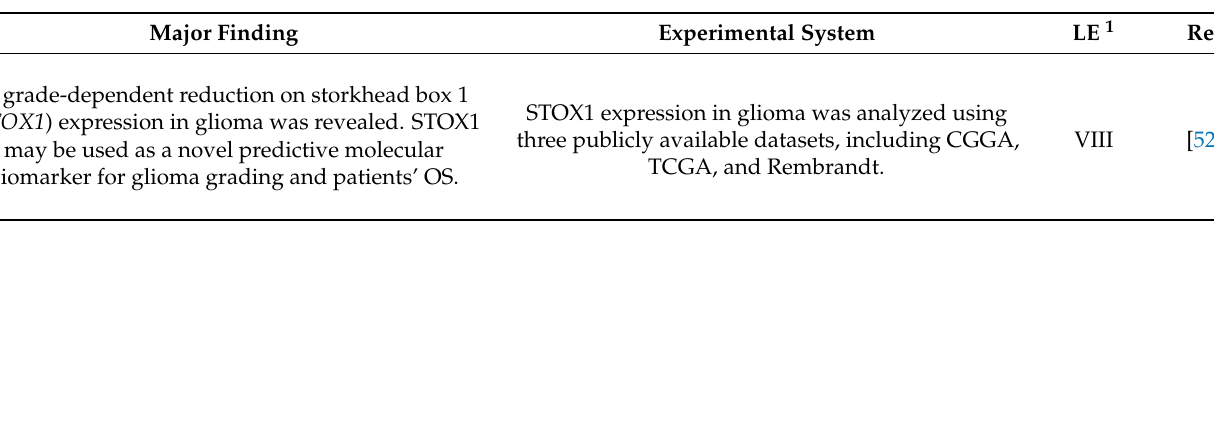
Table 2. Highlights of recent advances in the prognosis of